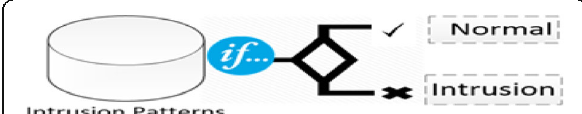
Fig. 2 Conceptual working of SIDS